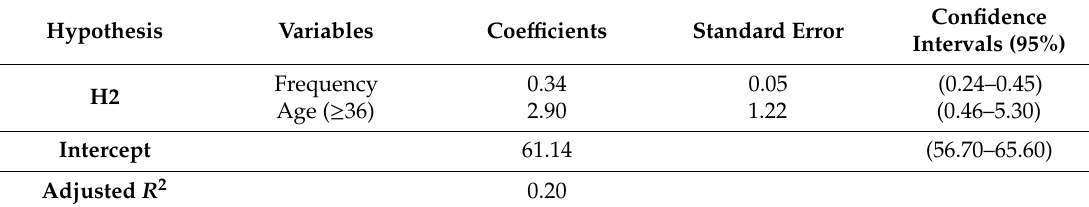
Table 4. Specifications for the regression of felt impacts as a function of frequency of environmental changes and age (H2, Model